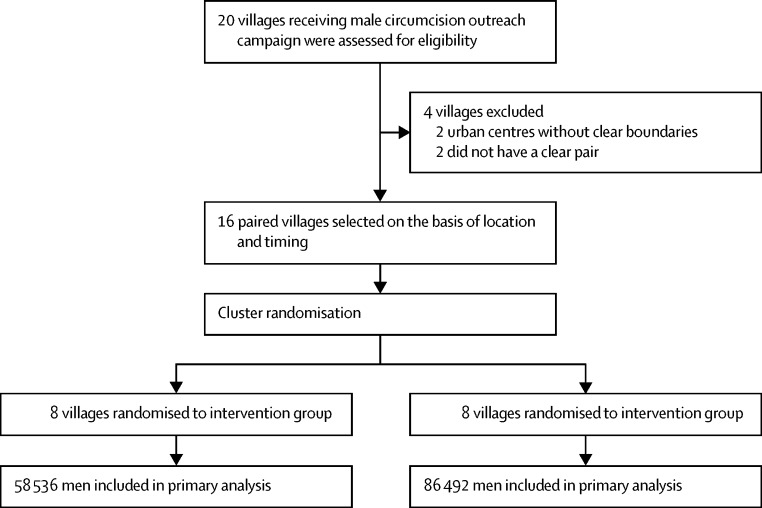
Overview of community randomisationAll men in all villages, based on the 2012 Tanzanian census data, were included in the analysis with no individual losses or exclusions.